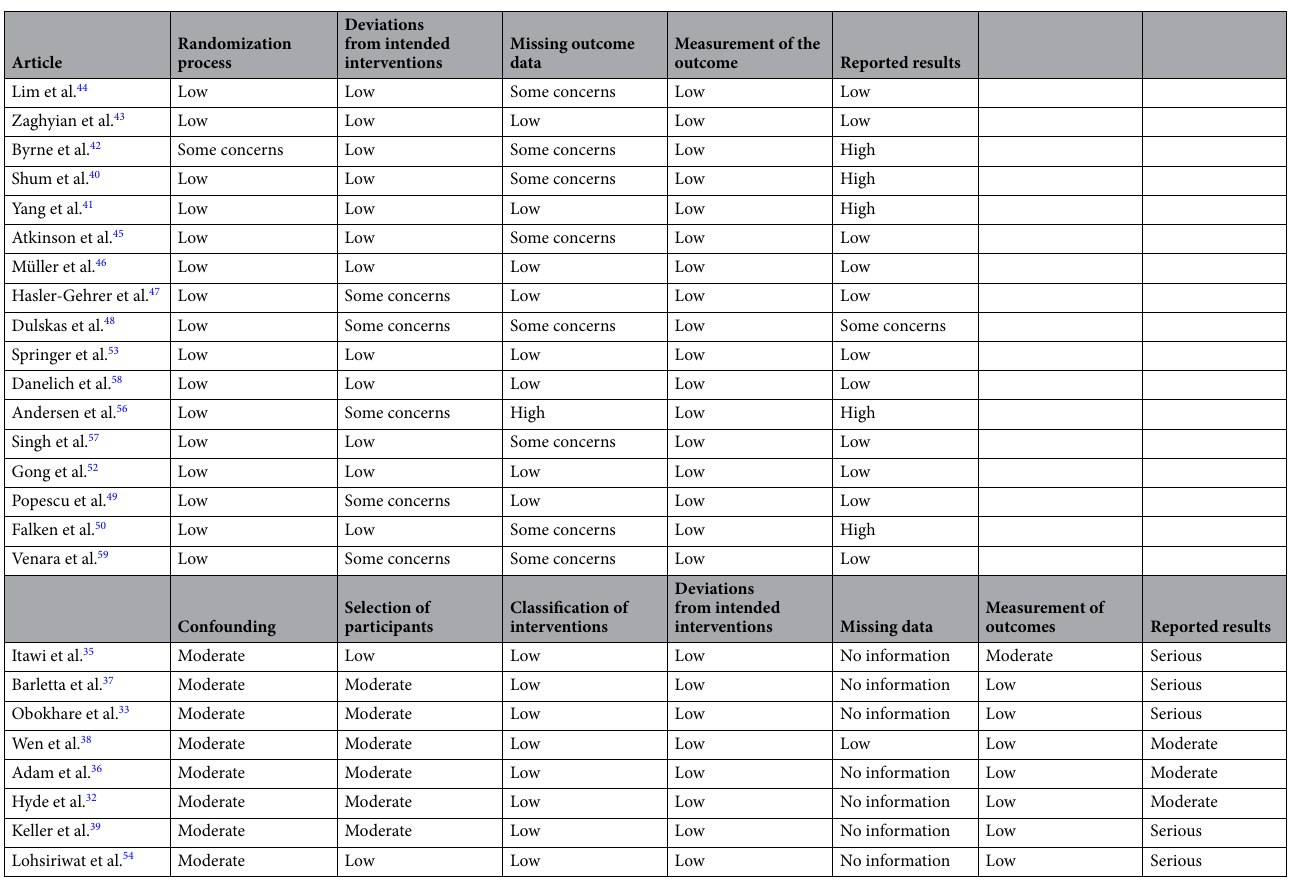
Table 4. Assessment of the risk of